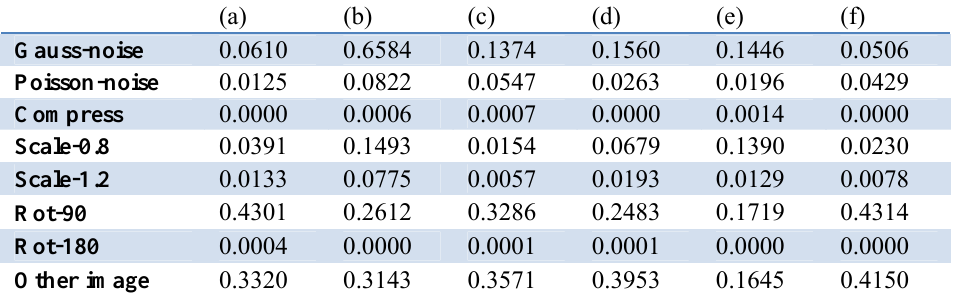
Table 5 Euclidean Distance of the normalized entropy matrixes’ sorted eigenvalue vector